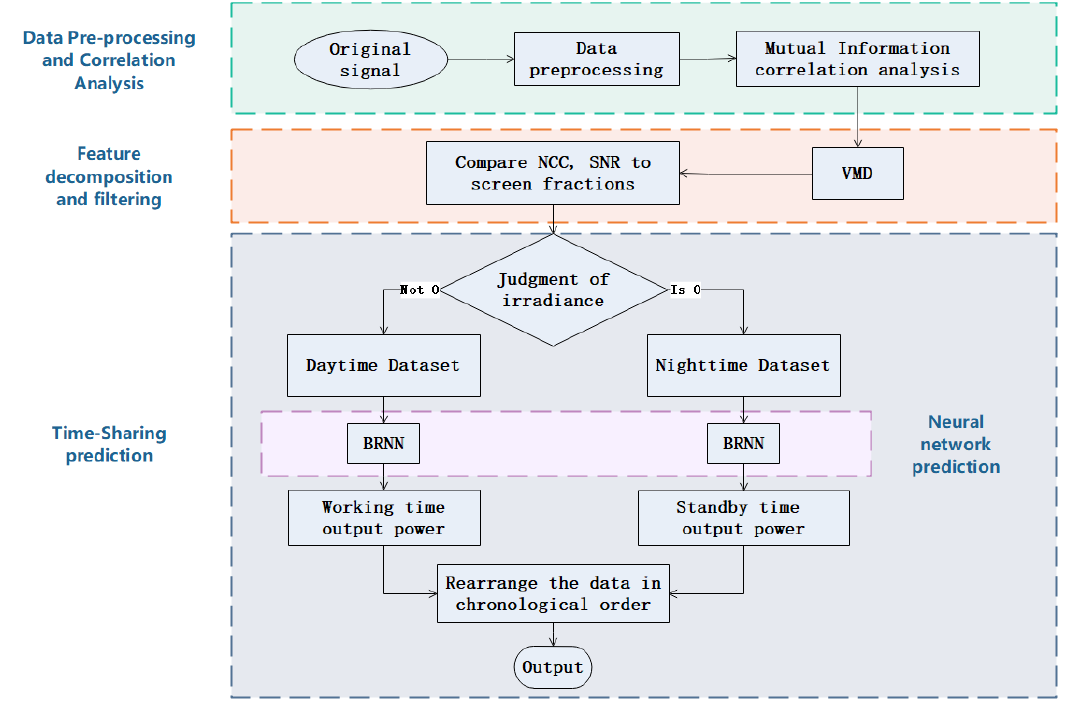
Figure 2. VMD-BRNN-TSP model